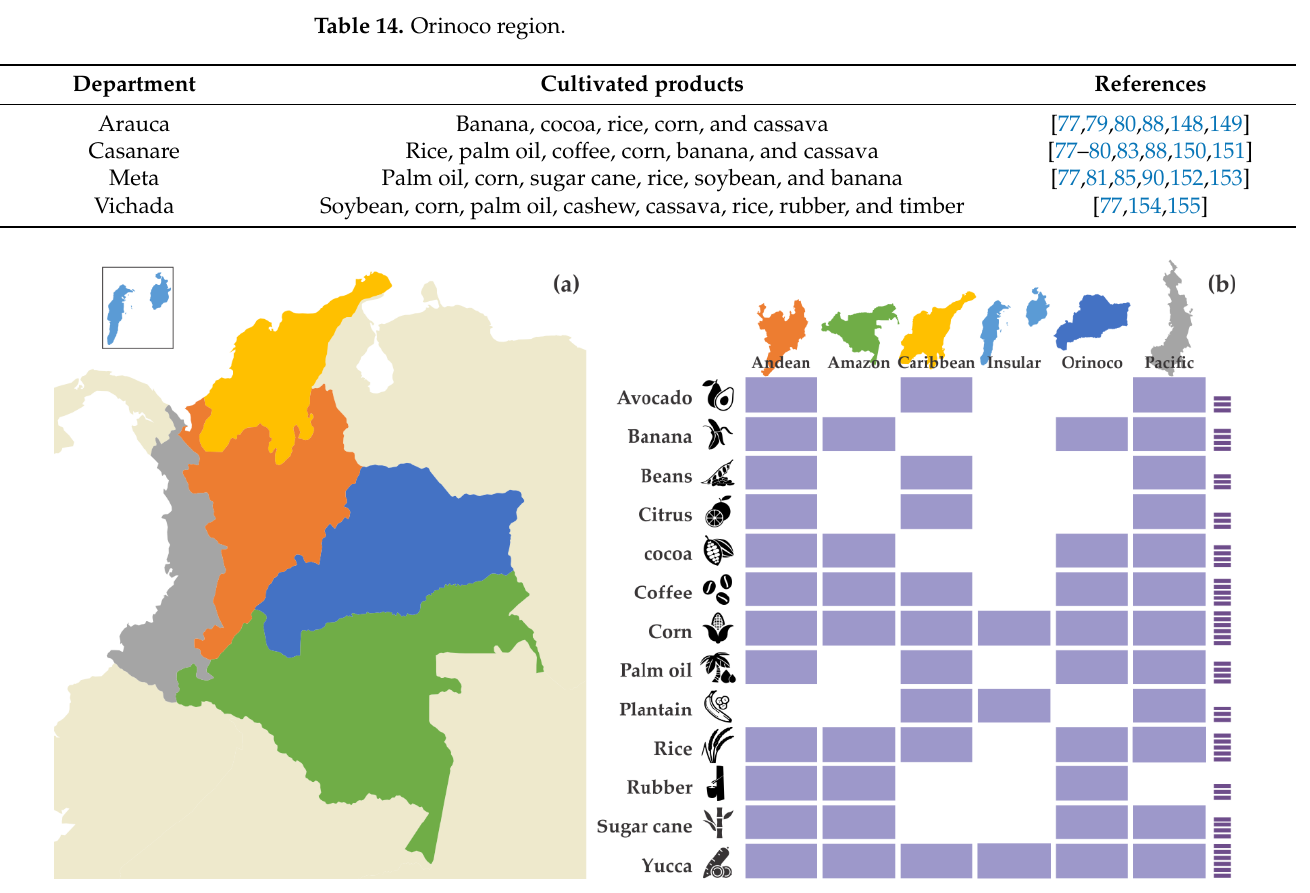
Figure 7. ( a ) Political map of Colombia’s regions; ( b ) agricultural products grown in most of the country’s regions.